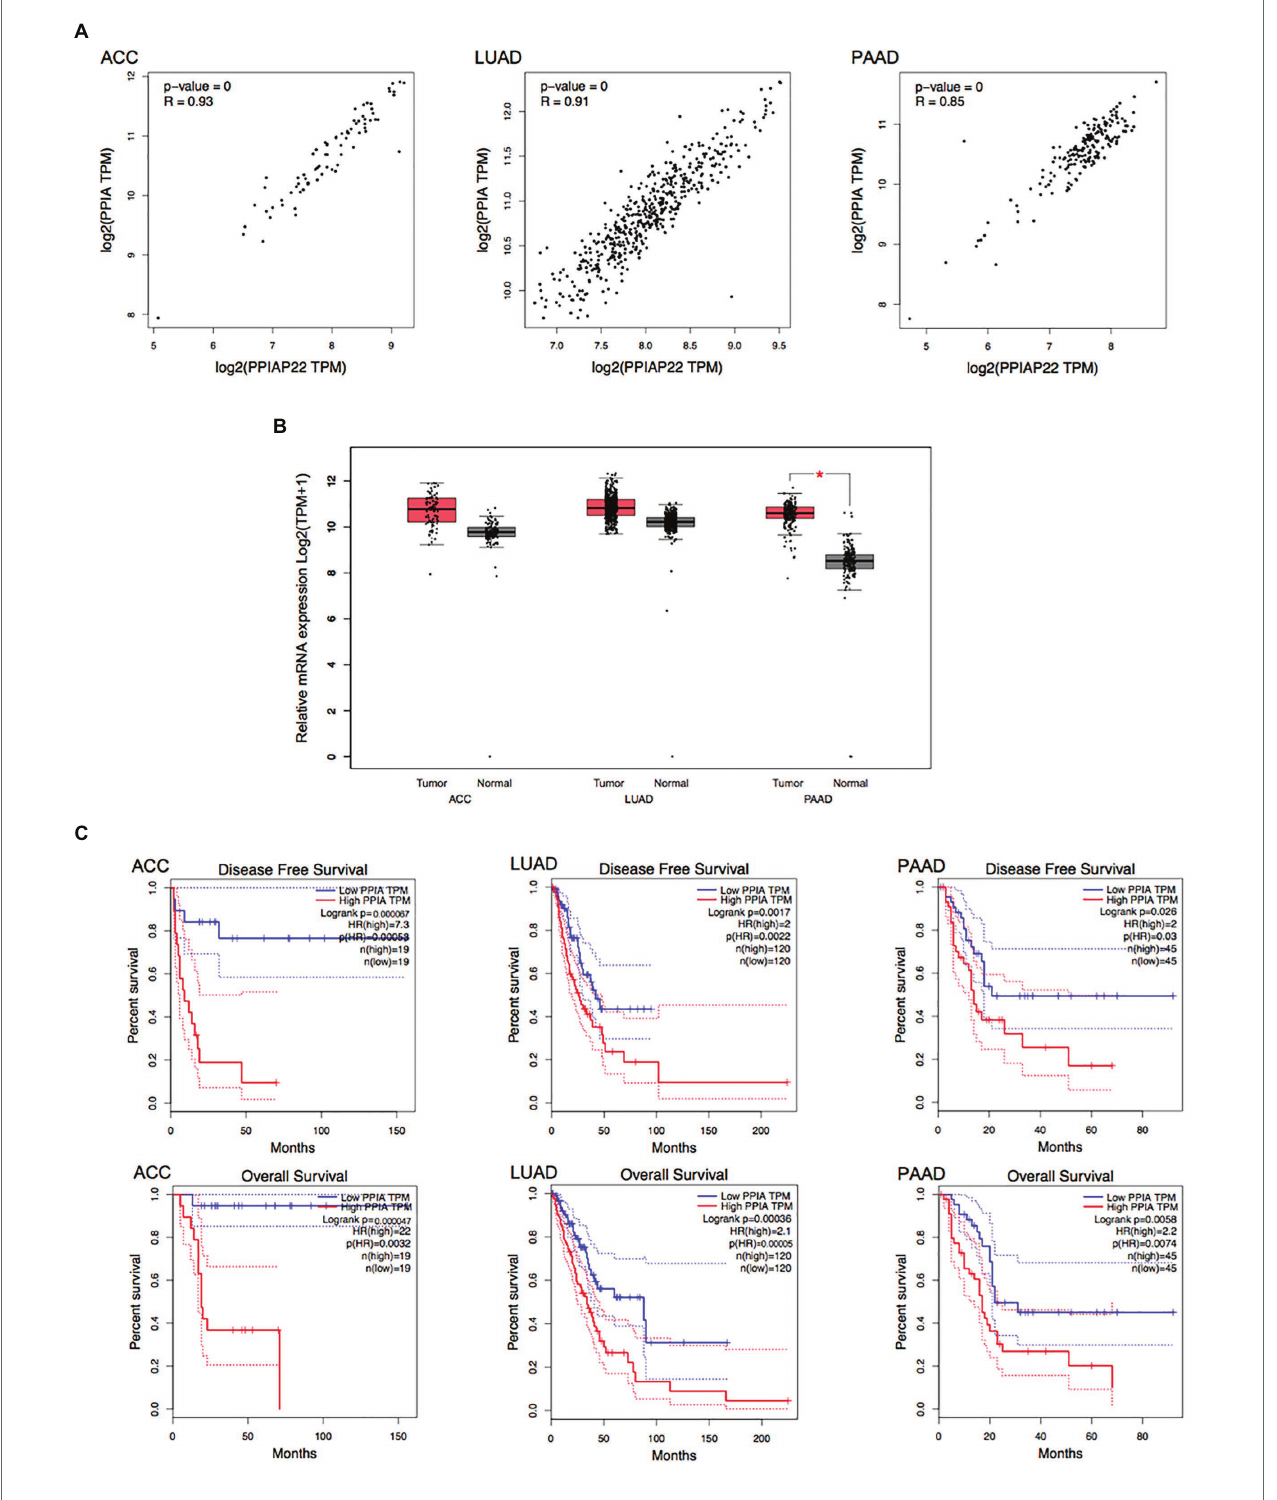
FIGURE 3 | Peptidylprolyl isomerase A plays a significant role in other types of cancer. (A) Correlation analysis between PPIAP22 and PPIA in ACC, LUAD, and PAAD using GEPIA. (B) PPIA was upregulated in ACC, LUAD, and PAAD identified by using TCGA and GTEx databases through GEPIA. (C) Prognostic values of PPIA in ACC, LUAD, and PAAD analyzed with GEPIA. The dotted lines represent the 95% CI. PPIAP22, peptidylprolyl isomerase A pseudogene 22; PPIA, peptidylprolyl isomerase A; ACC, adrenocortical carcinoma; LUAD, lung adenocarcinoma; and PAAD, pancreatic adenocarcinoma. * p <